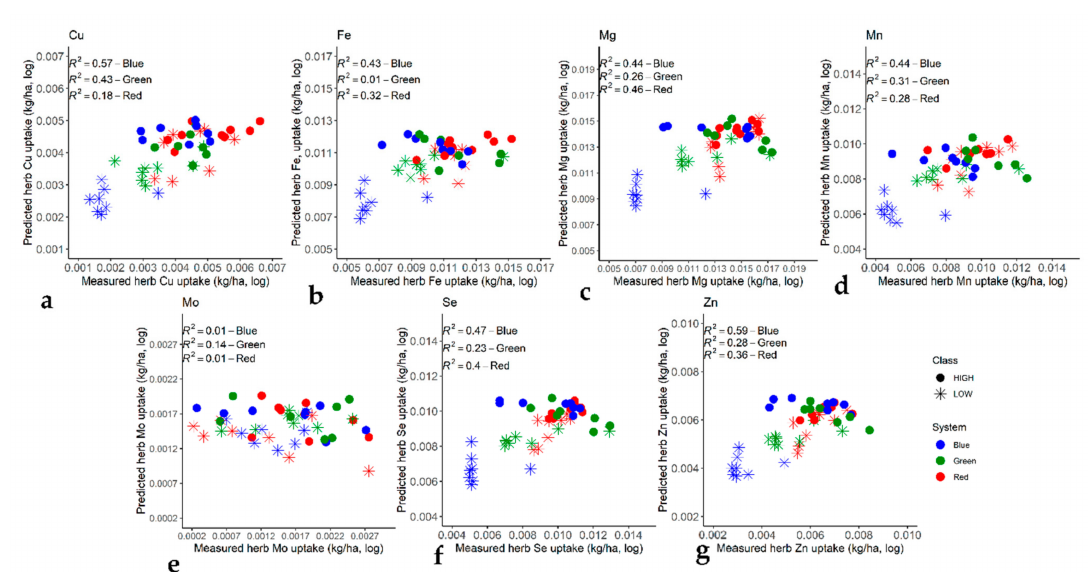
Figure 3. Measured and site/soil calibration model cross-validation-predicted herbage micro-nutrient uptake (nutrient concentration × yield) in the whole set (n = 48): ( a ) Cu, ( b ) Fe, ( c ) Mg, ( d ) Mn, ( e ) Mo, ( f ) Se and ( g ) Zn. At locations selected as high (circles) or low (stars) soil total micro-nutrient content; 8 high and 8 low locations in each of the pasture systems: high-sugar grass + legume mix − N fertilizer (blue/HSG + L), permanent pasture + N fertilizer (green/P + N), high-sugar grass + N fertilizer (red/HSG + N). NB, all herbage data were log